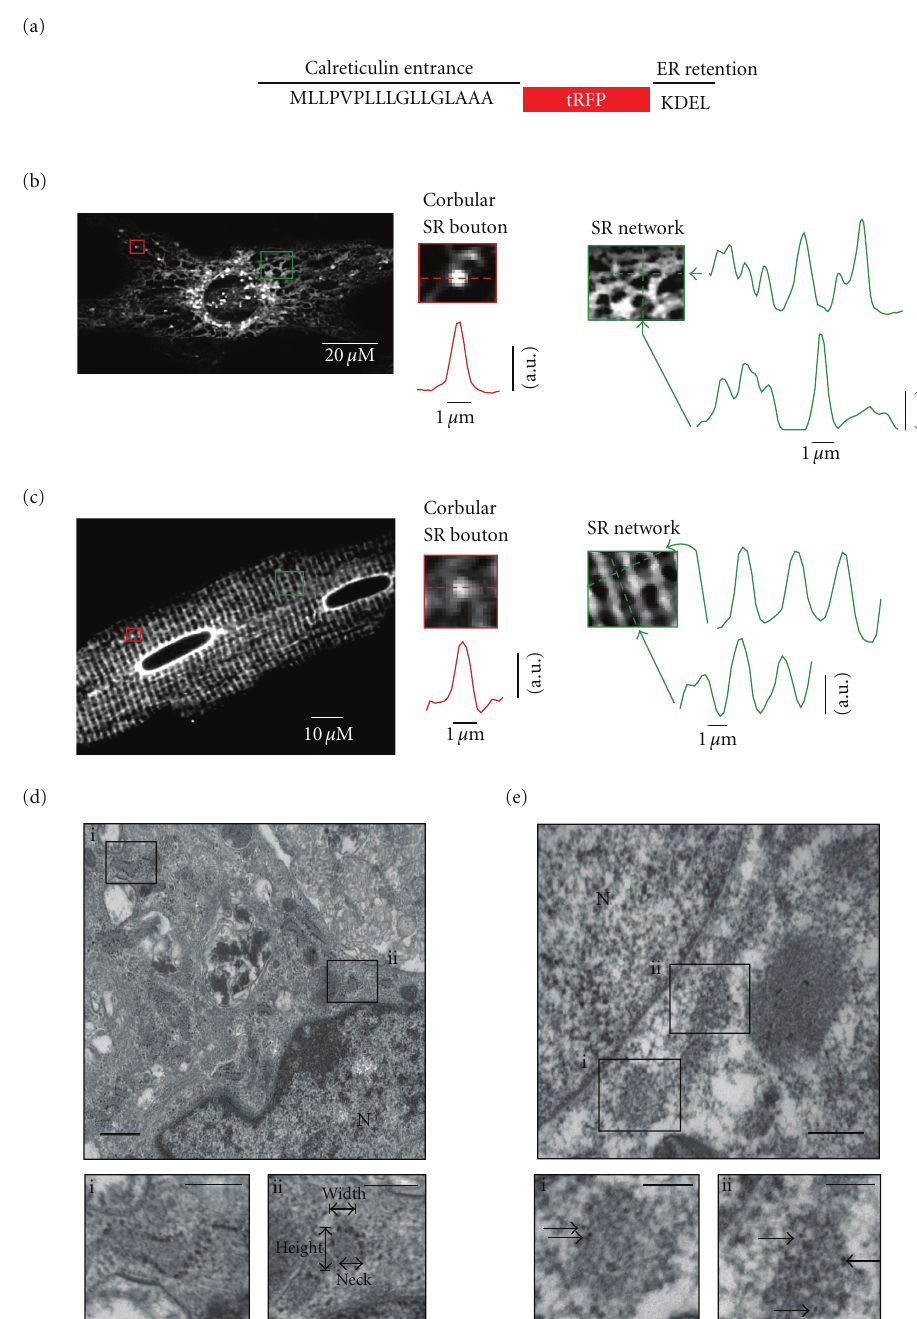
Figure 2: Imaging of network, junctional, and corbular SR boutons in living and fixed ventricular myocytes. (a) A cartoon of the tRFP-SR construct. (b) Confocal image of representative living neonatal ventricular myocyte expressing tRFP-SR. (c) Confocal images of representative living adult ventricular myocyte. Insets show zooms of a corbular SR bouton (red box) and SR network (green box) in these cells. Graphs show fluorescence intensity profile in the region in the image marked by arrows. (d) Electron microscopy image of non- permeabilized neonatal ventricular myocytes infected with tRFP-SR (scale bar = 1 μ m; N = nucleus). Insets depict invaginations of the endoplasmic/sarcoplasmic reticulum (scale bar = 100 nm). Panel Dii shows an example of how the dimensions of SR boutons were made. (e) Immunogold labeling of tRFP-SR (arrows of insets) from a permeabilized neonatal ventricular myocyte infected with tRFP-SR depicting invaginations of the endoplasmic/sarcoplasmic reticulum (scale bar = 500 nm and 100nm (insets); N =